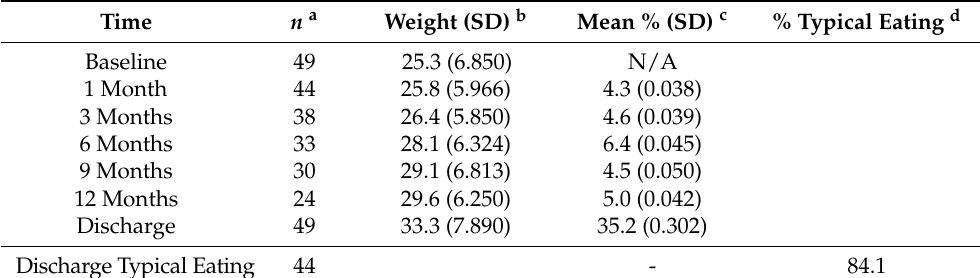
Table 3. Failure to Thrive—Percentage Increase in Weight.